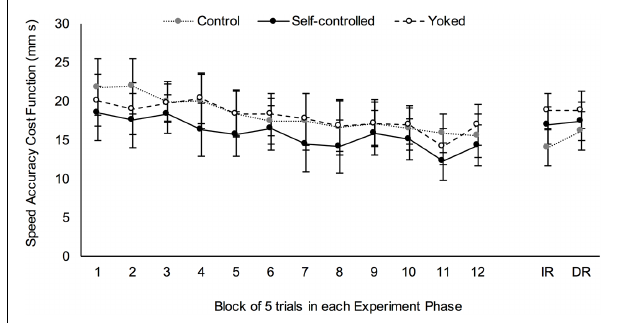
FIGURE 2 | Overall performance efficiency (as measured by the speed accuracy cost function) for each group of participants in each phase of the experiment. Blocks of acquisition are numbered 1 through 12 and retention tests are IR (immediate retention) and DR (delayed retention). Error bars are 95% CI of the